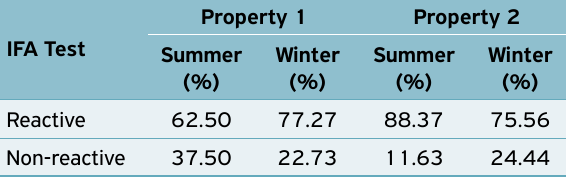
Table 2. Frequency distribution accordingly with reactiveness to indirect immunofluorescent assay (IFA) test at cut‑off titer (1:160), property and season of the year, in an Anaplasma phagocytophilum serosurvey in two regions of Minas Gerais state, Brazil. IFA